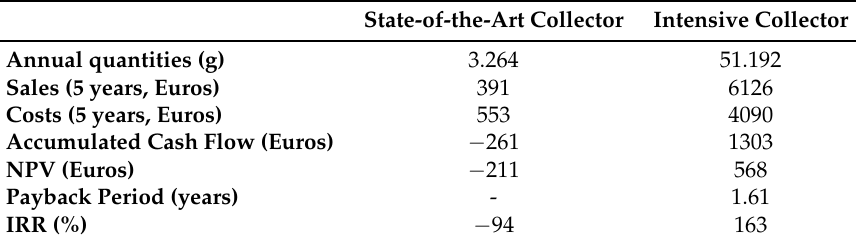
Table 11. Compared